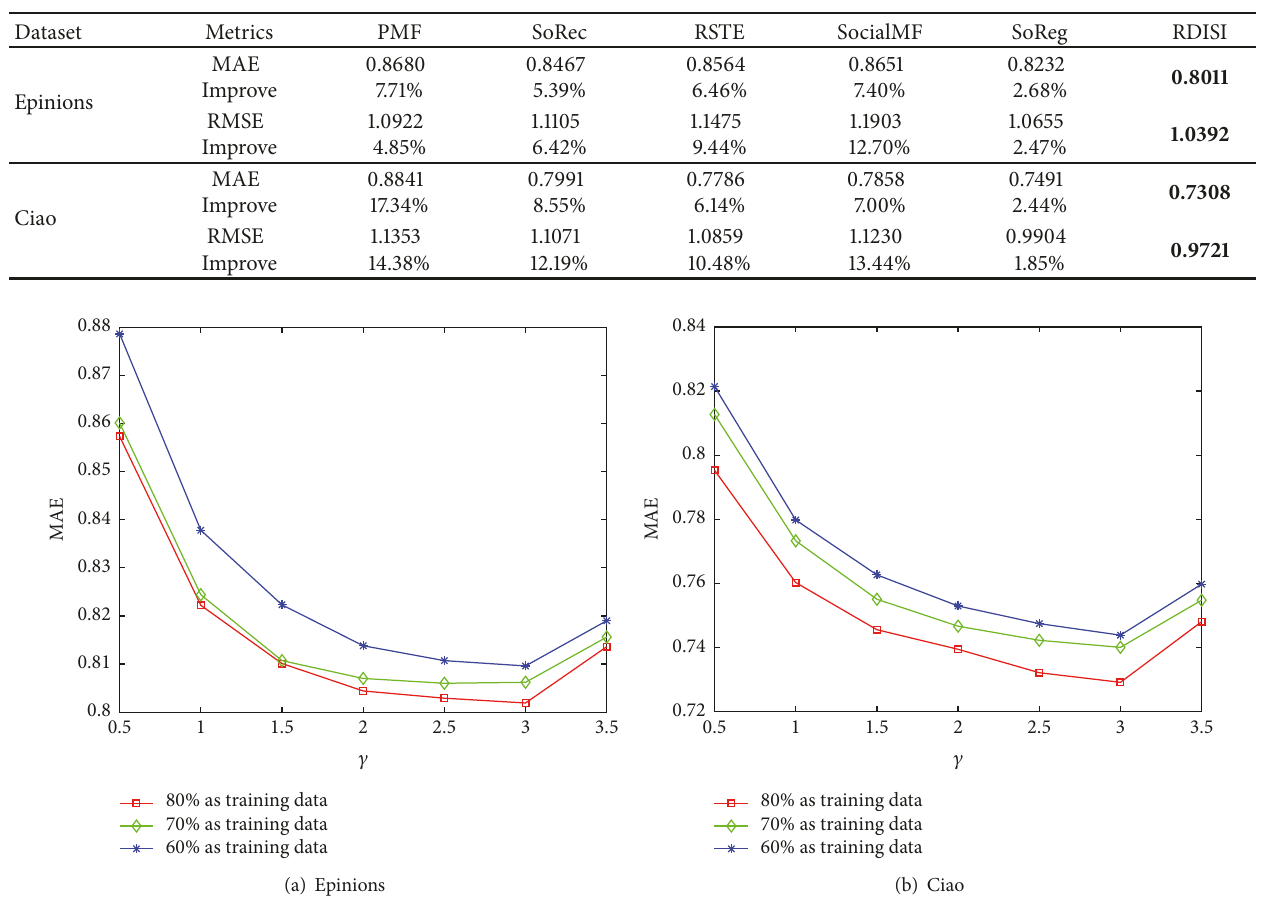
Table 3: Performance comparisons (MAE and RMSE).